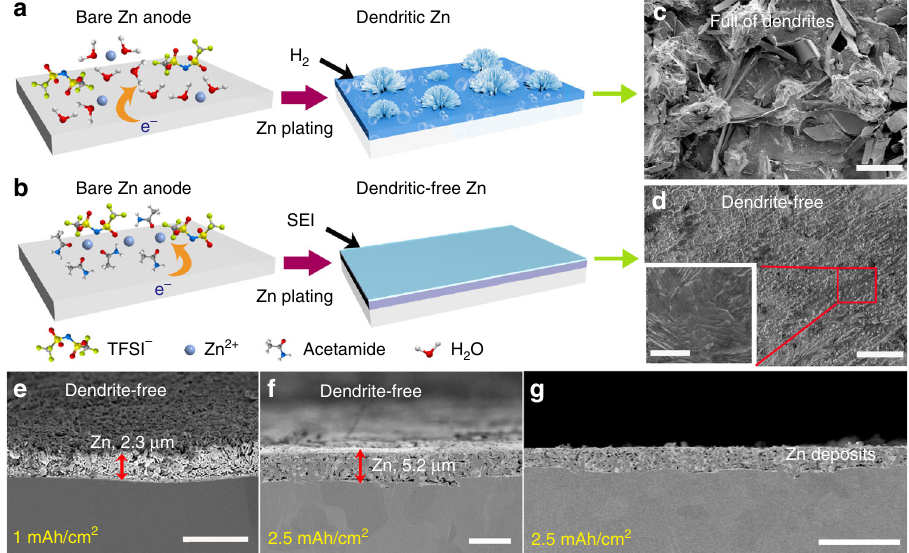
Fig. 3 Effect of ZES and as-obtained SEI layer on Zn deposition. a Zn dendrite growth along with H 2 evolution observed in 1M Zn(TFSI) 2 and b SEI-regulated uniform Zn deposition in ZES. SEM images of Zn deposits using c 1M Zn(TFSI) 2 and d ZES electrolytes at 1mAcm − 2 (0.5mAhcm − 2 ). e – g Cross-sectional SEM images of Zn deposits which were obtained in ZES electrolyte with 1mAhcm − 2 (0.25mAcm − 2 ) ( e ) and 2.5mAhcm − 2 (0.5mAcm − 2 ) ( f ) Zn on Zn substrate, respectively. g A lower-magni fi cation image of panel ( f ) showing a large area of uniform deposition. Scale bar: 50 μ m for ( c ), ( d ); 2 μ m for ( e ); 5 μ m for ( f ); 20 μ m for ( g ) and inset in ( d (Fig. 3d inset), also corresponding to the surface modi fi cation. Thus, it is reasonable to assume that this additional Zn-electrolyte interphase dictates the reversible Zn/Zn 2 + redox with ef fi cient Zn 2 + transport and deposition (Fig. 3b).